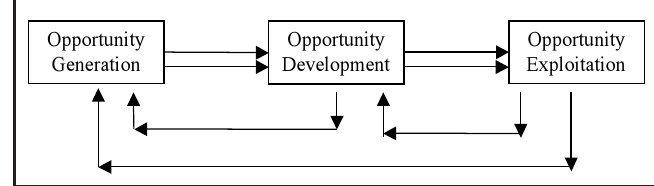
Figure 2. The Entrepreneurial Process